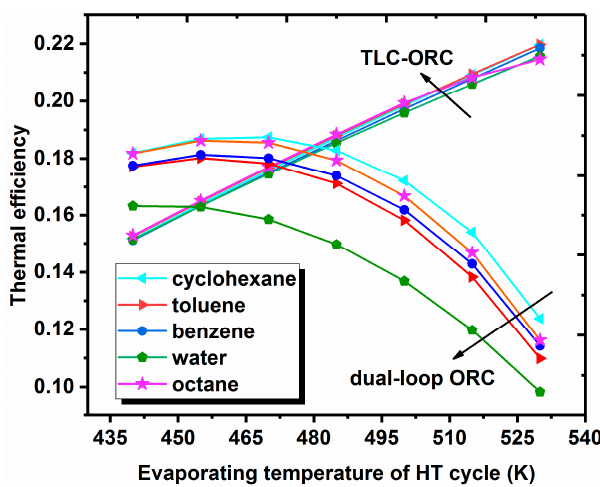
Figure 6. Comparison of thermal efficiency between the two systems under different T HT,evap .